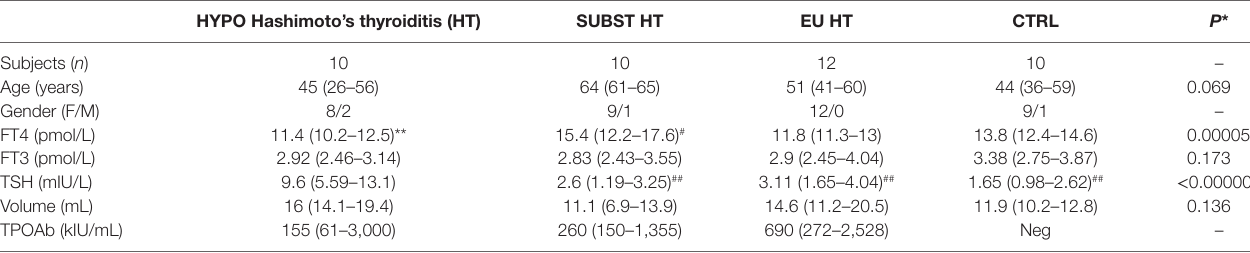
TaBle 2 | Descriptive analysis of clinical and biochemical characteristics of patients and healthy